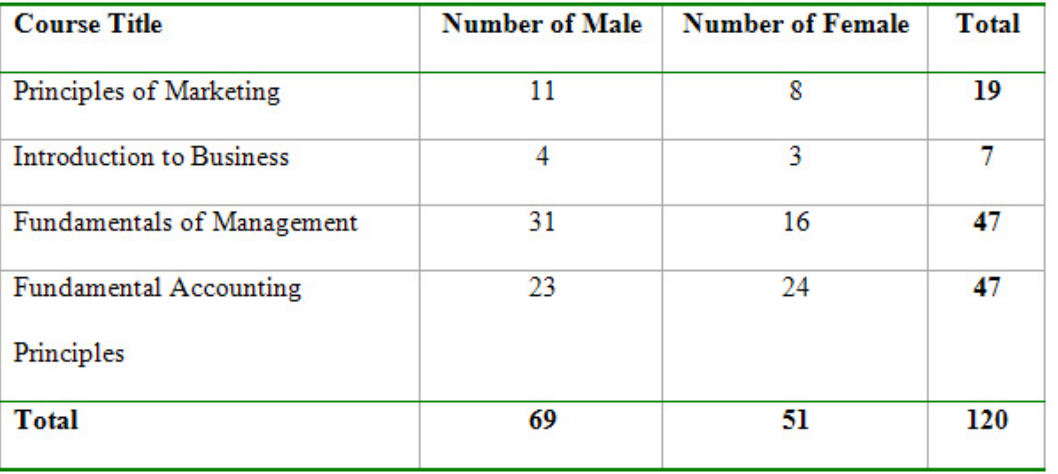
Table 2. Second Round Scholarship Distribution by Course and